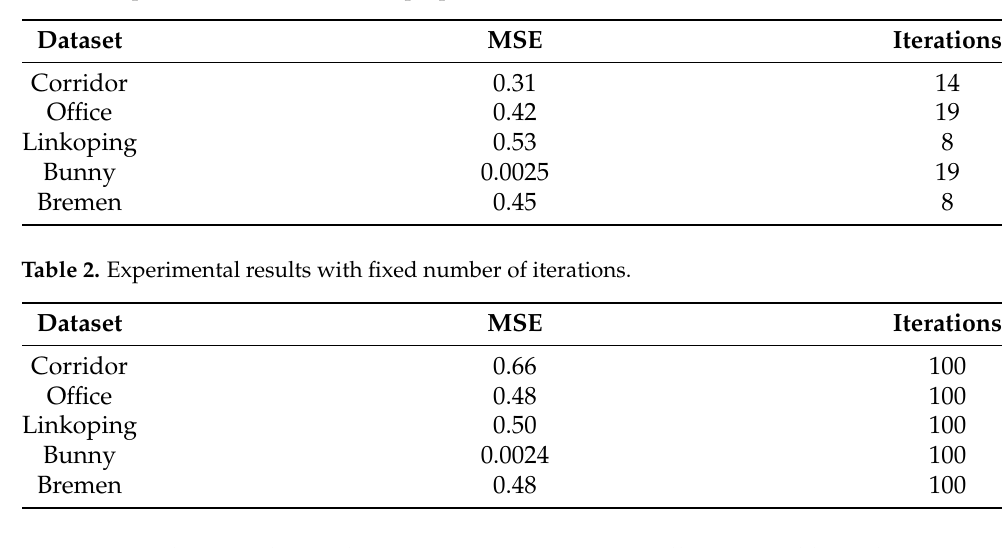
Table 1. Experimental results with the proposed termination criterion.